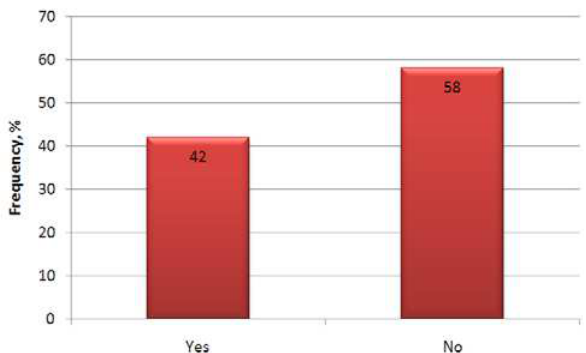
Fig. 12. Level of awareness of organizations helping farmers with information and training